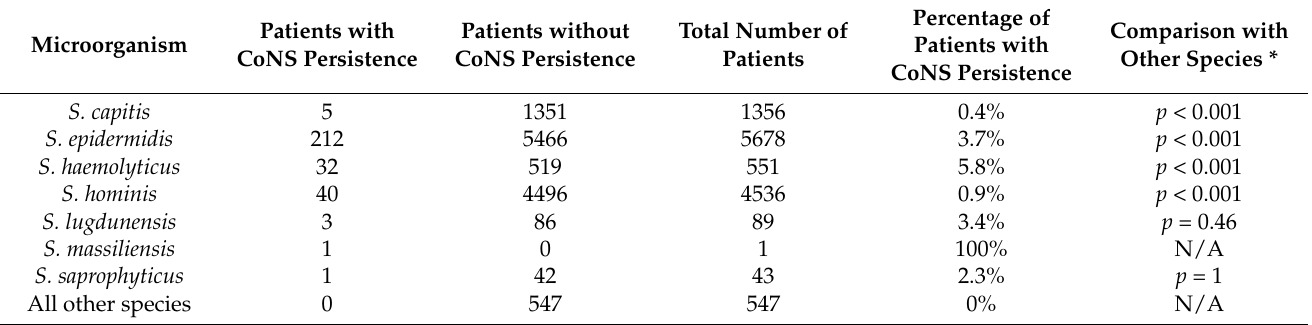
Table 4. The number of patients with and without CoNS persistence per